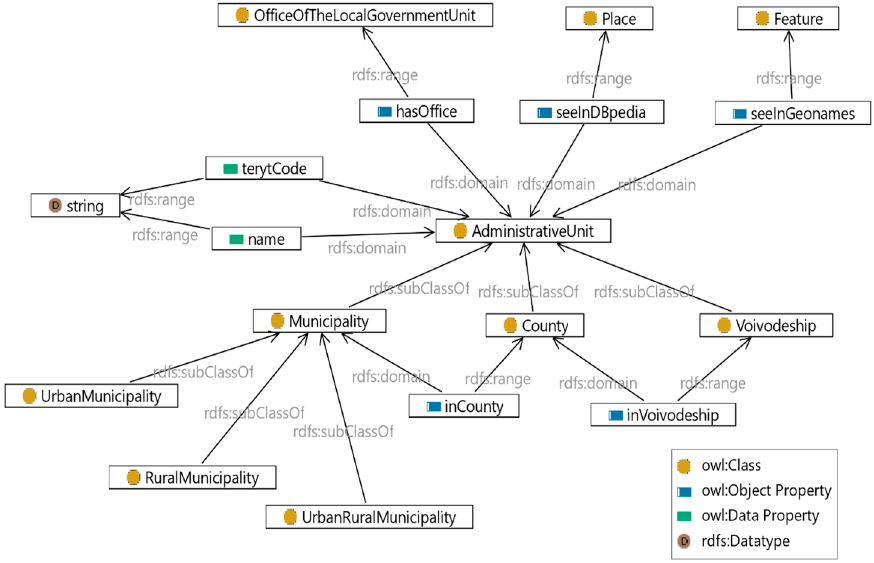
Figure 5. A part of the domain ontology for the National Register of Boundaries (visualization created with TopBraid Composer).